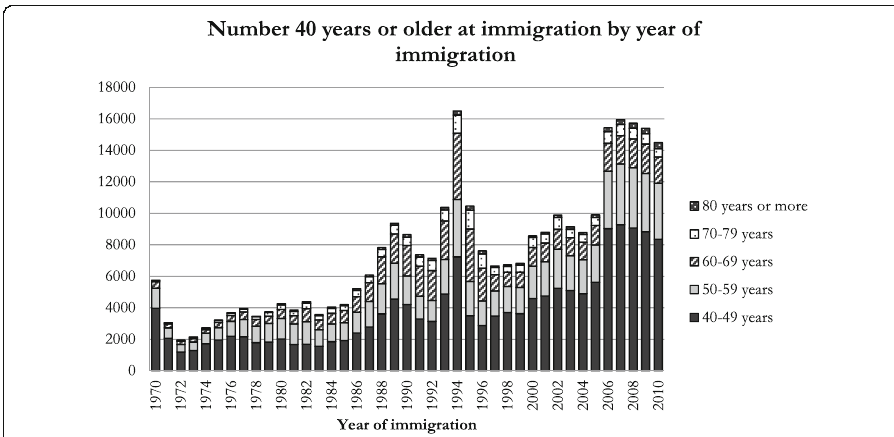
Fig. 2 Number 40 years or older at immigration by year of